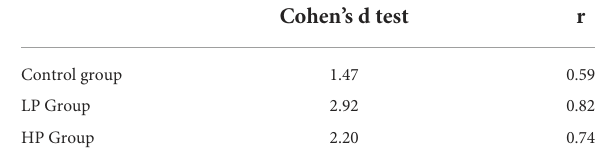
TABLE 1 Means, typical deviations and gainings from the TEMA-3 test between the pre- and post intervention phases.